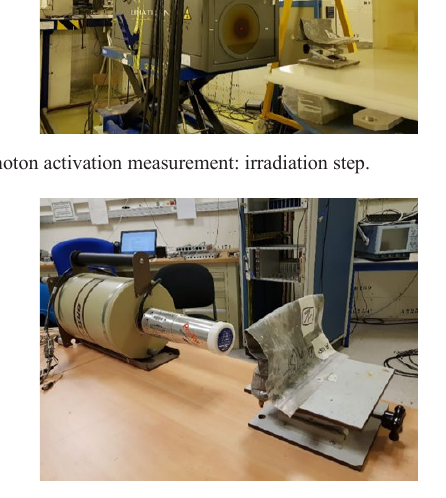
Fig. 3. Photon activation measurement: delayed gamma-ray detection step.